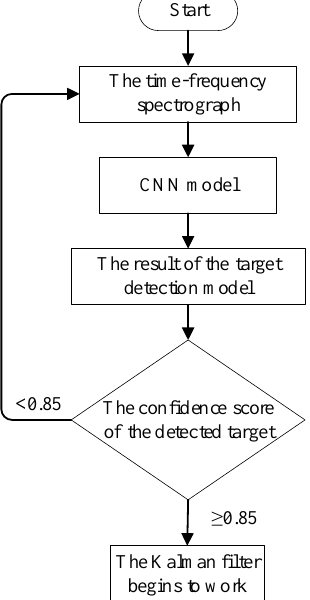
Figure 6. The flowchart of the target detection model.